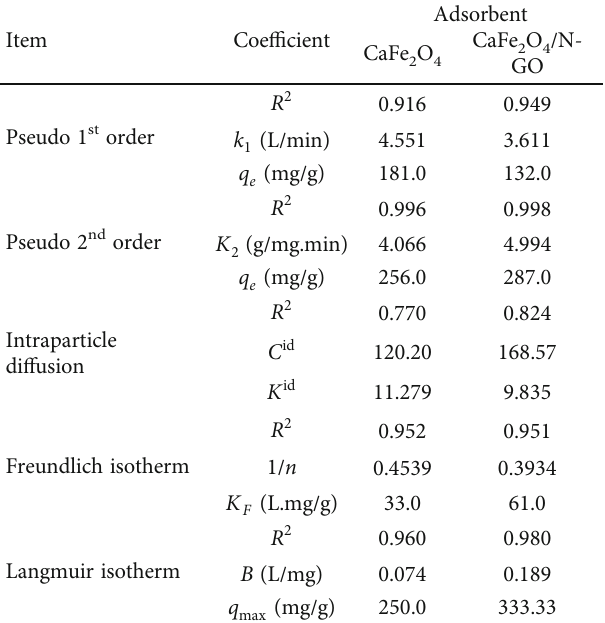
Table 2: The kinetics and isotherm parameters for the removal